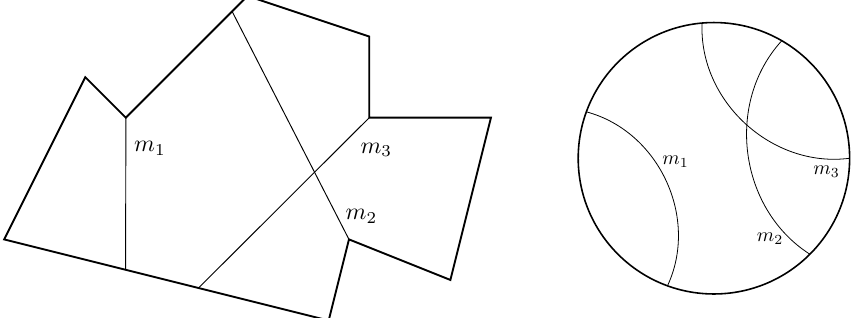
Figure 14. Polygon with motorcycles ( left ) and its abstraction on a disk ( right